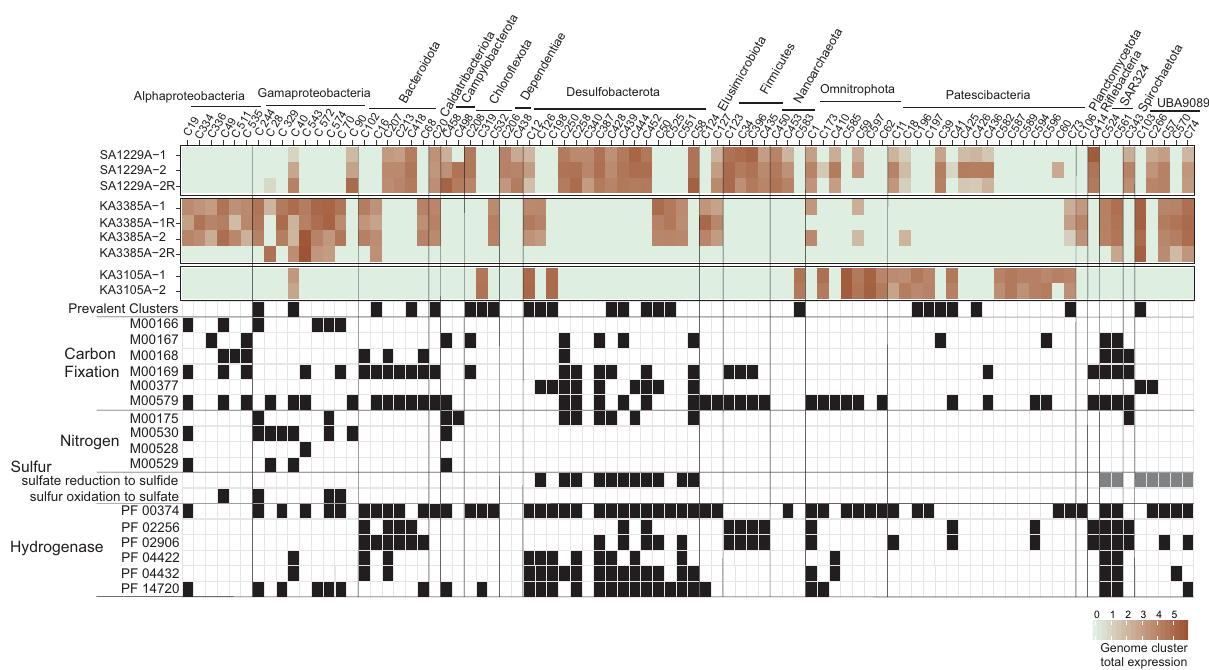
Fig. 5 Expression pro fi le and metabolic context of the highly expressing genomic clusters. The expression pro fi le of genome clusters with a total expression ≥ 10,000 TPM and their metabolic potential for nitrogen and sulfur energy metabolism as well as carbon fi xation is represented as KEGG modules presence only if all genes of the module or the key genes of the process are present (in black). Reductive pentose phosphate cycle, ribulose-5P ≥ glyceraldehyde-3P (M00166), reductive pentose phosphate cycle, glyceraldehyde-3P ≥ ribulose-5P (M00167), Crassulacean acid metabolism, dark (M00168) and light (M00169), reductive acetyl-CoA pathway (Wood-Ljungdahl pathway) (M00377), and phosphate acetyltransferase-acetate kinase pathway, acetyl-CoA ≥ acetate (M00579). Nitrogen fi xation (M00175), dissimilatory nitrate reduction (M00530), nitri fi cation (M00528), and denitri fi cation (M00529). Genes involved in the dissimilatory sulfur metabolism are shown in Supplementary Data 7. Squares highlighted in gray contain genes for sulfate reduction to sul fi de but are missing dsrD. Nickel-dependent hydrogenase (PF00374), iron hydrogenase (PF02256 and PF02906), coenzyme F420 hydrogenase/dehydrogenase (PF04422 and PF04432), and NiFe/NiFeSe hydrogenase